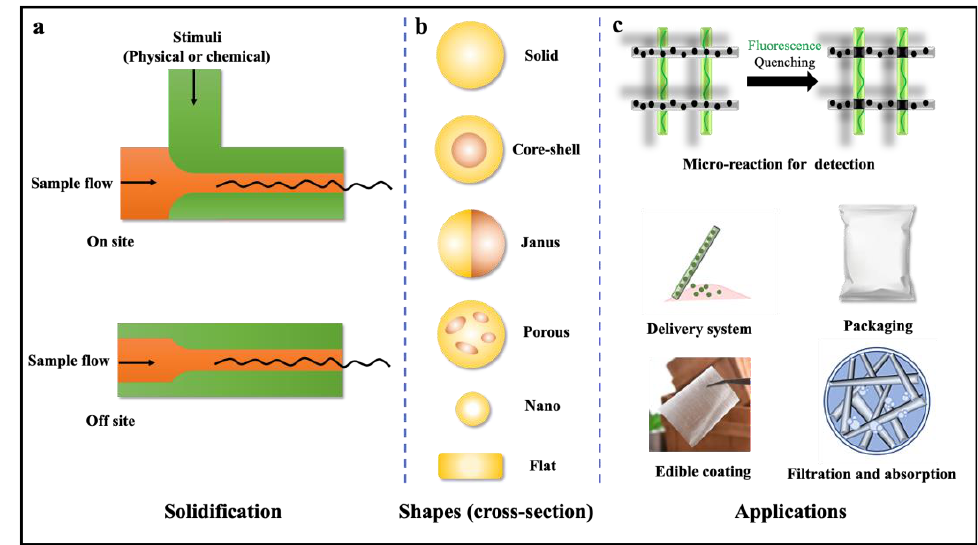
Figure 3. Fabrication of microfibers/films and their applications in food processing and analysis. ( a ) On-site and off-site solidification of microfibers. ( b ) Microfibers with diverse shapes. ( c ) Potential applications of microfibers for MST.